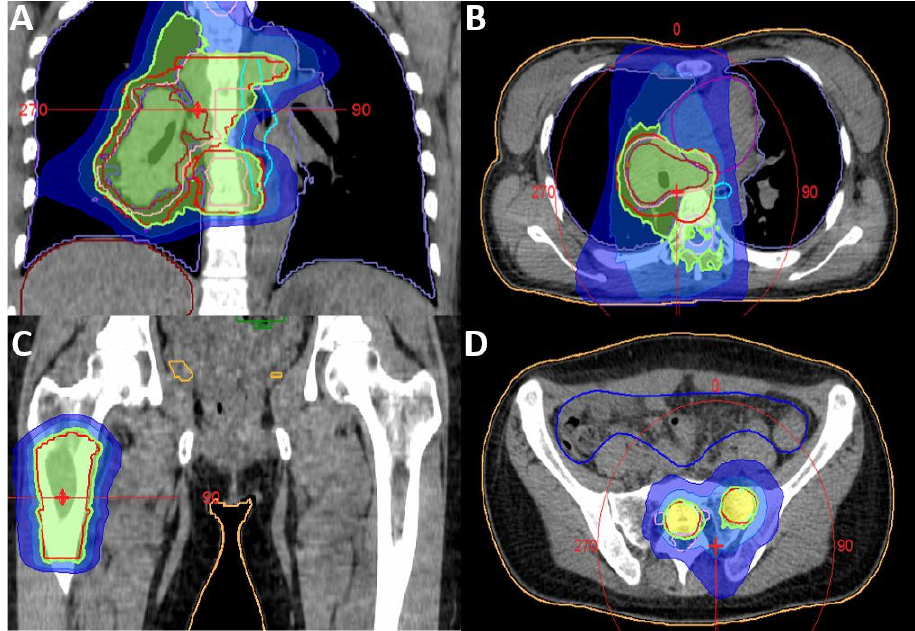
Figure 3. Radiotherapy volumes of “multi ‐ site” radiotherapy of a 34 ‐ year ‐ old woman with stage IV NSCLC: primary tumour & Th8 ‐ 9 ( A / B ), right Femur ( C ) and sacral lesions ( D ). Dose concept for all locations: 5 × 4.0 Gy.